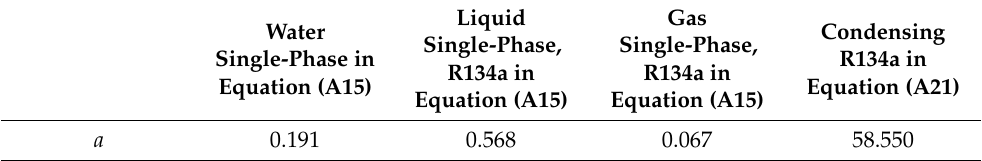
Table A2. The calculated empirical coefficients of the thermal model of the